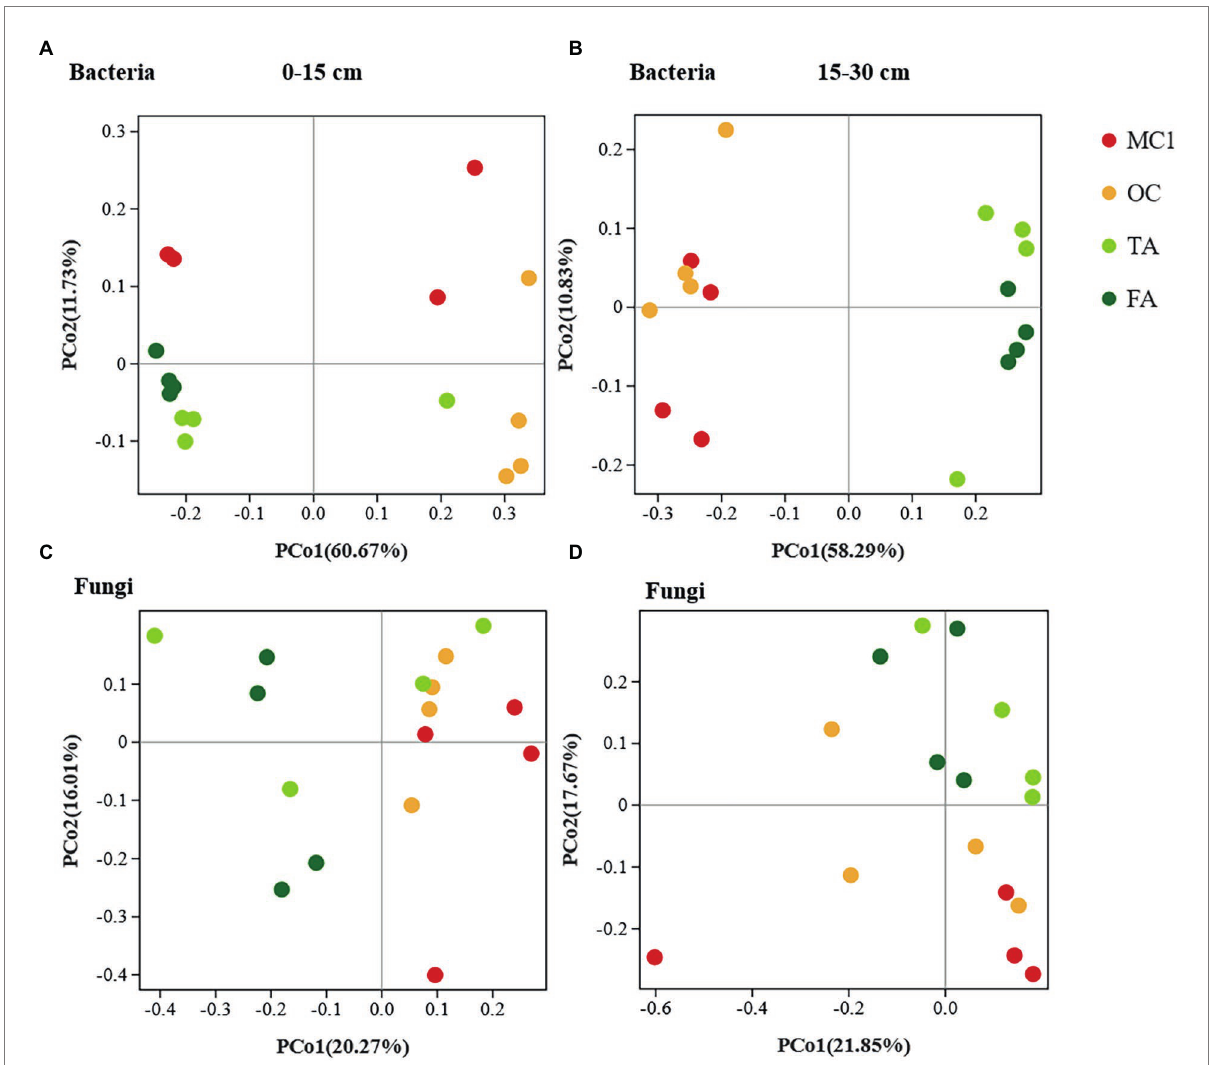
FIGURE 1 The PCoA of soil bacteria and fungals at different soil depths. The PCoA of soil bacteria at the 0-15 cm soil depth (A) and the 15-30 cm soil depth (B) . PCoA of soil fungi at the 0-15 cm soil depth (C) and the 15-30 cm soil depth (D)